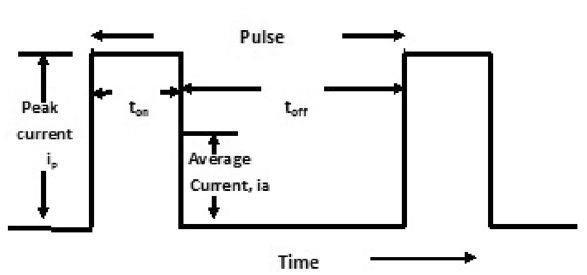
Fig. 2 Typical waveform of a pulse deposition mode of